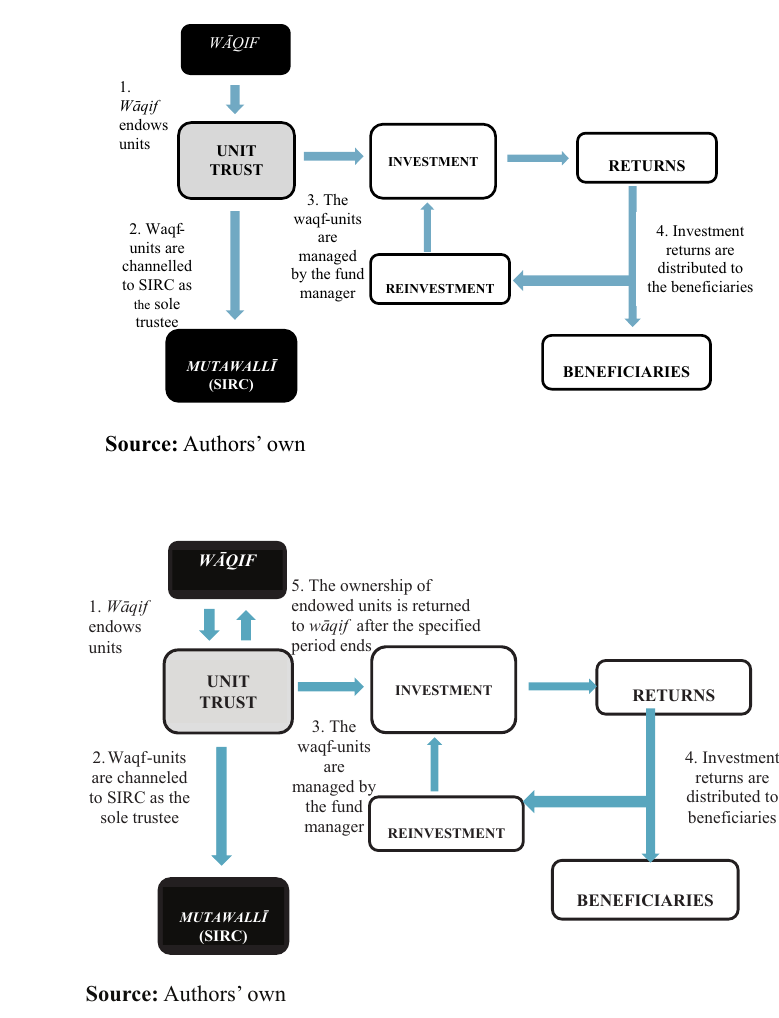
Figure 3. Second proposed model: waqf mu ʾ aqqat model